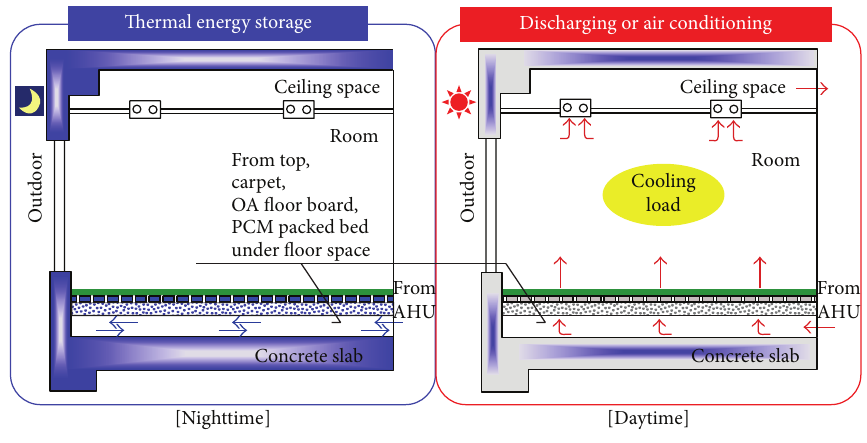
Figure 15: Concept of the